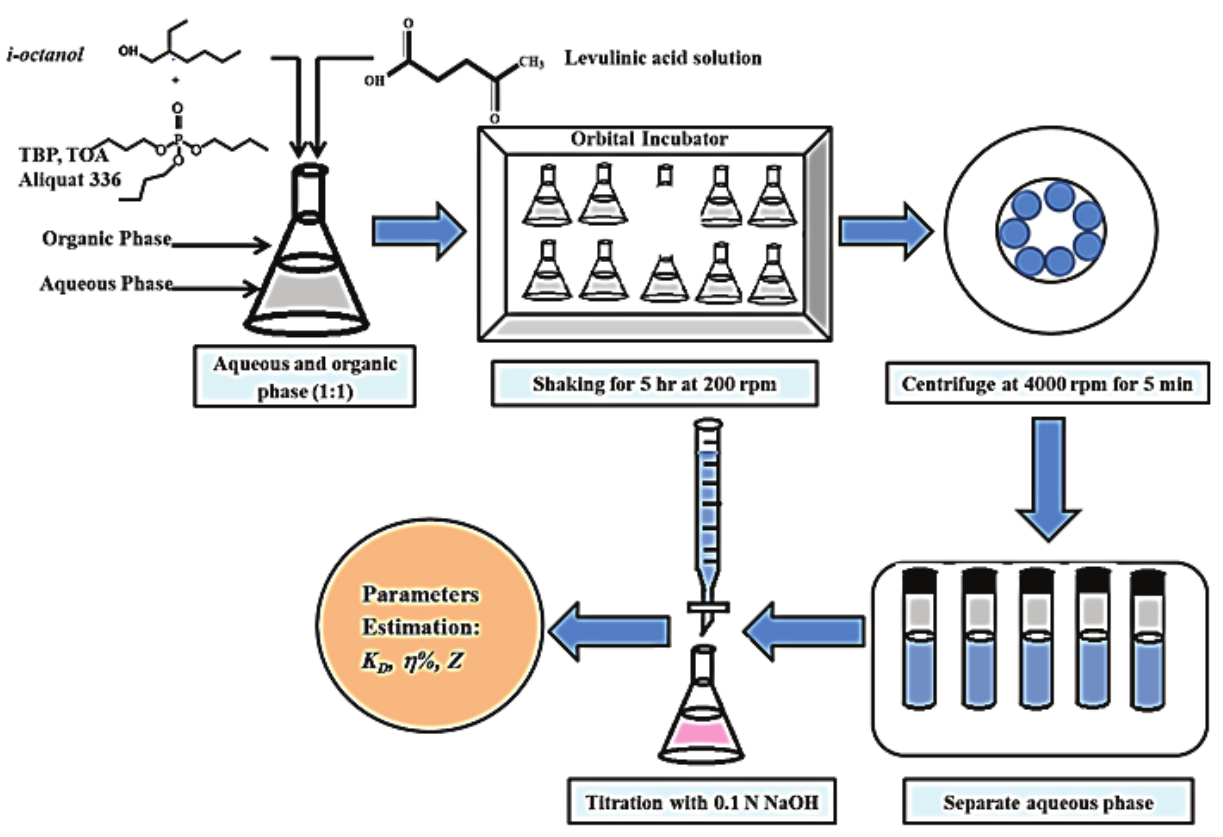
Fig. 1 – Block diagram of the experimental procedure for the separation of levulinic